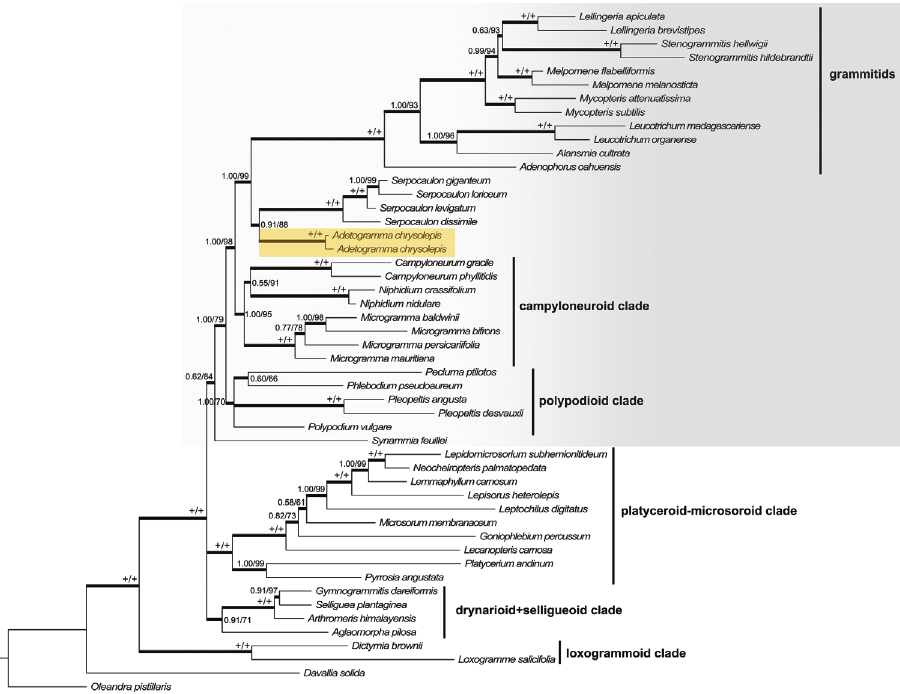
Figure 1. Majority rule consensus tree resultant from Bayesian inference analyses from combined rbc L and rps 4 datasets. Values above branches nodes correspond to Bayesian posterior probabilities and maxi- mum likelihood bootstrap support, respectively. +/+ indicates with 1.00 PP and 100% BS support. Clades cited in text follow Schneider et al. (2004); gray shade indicates neotropical Polypodiaceae. Adetogramma chrysolepis is highlighted in